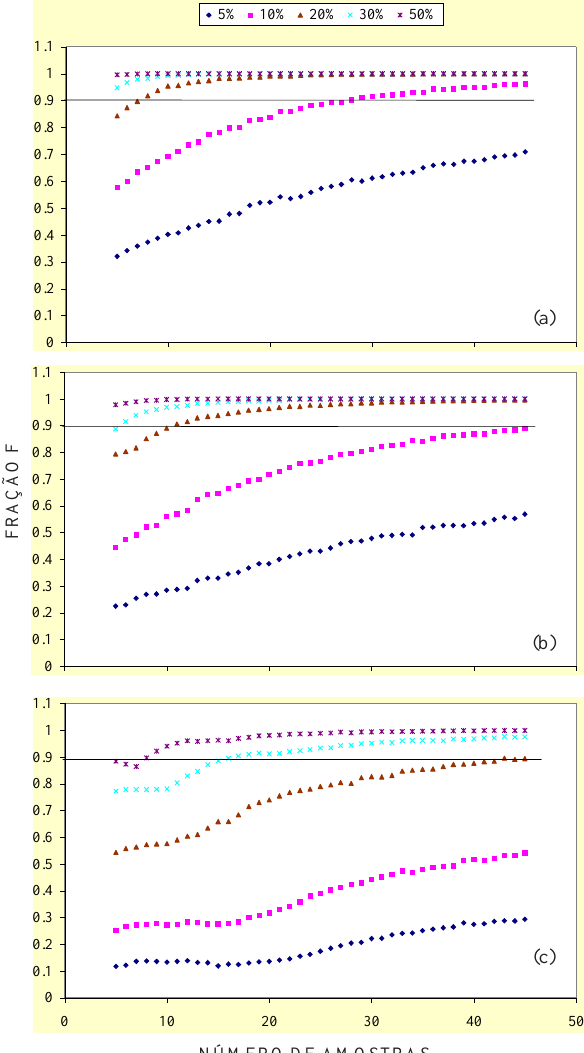
Figura 4. Fração da amostra “bootstrap” para , considerando 5, 10, 20, 30 e 50 % de lnK qqqqq =0 variação em torno da média e do tamanho da amostra, nas profundidades de 0,30 (a), 0,45 (b) e 0,60 m